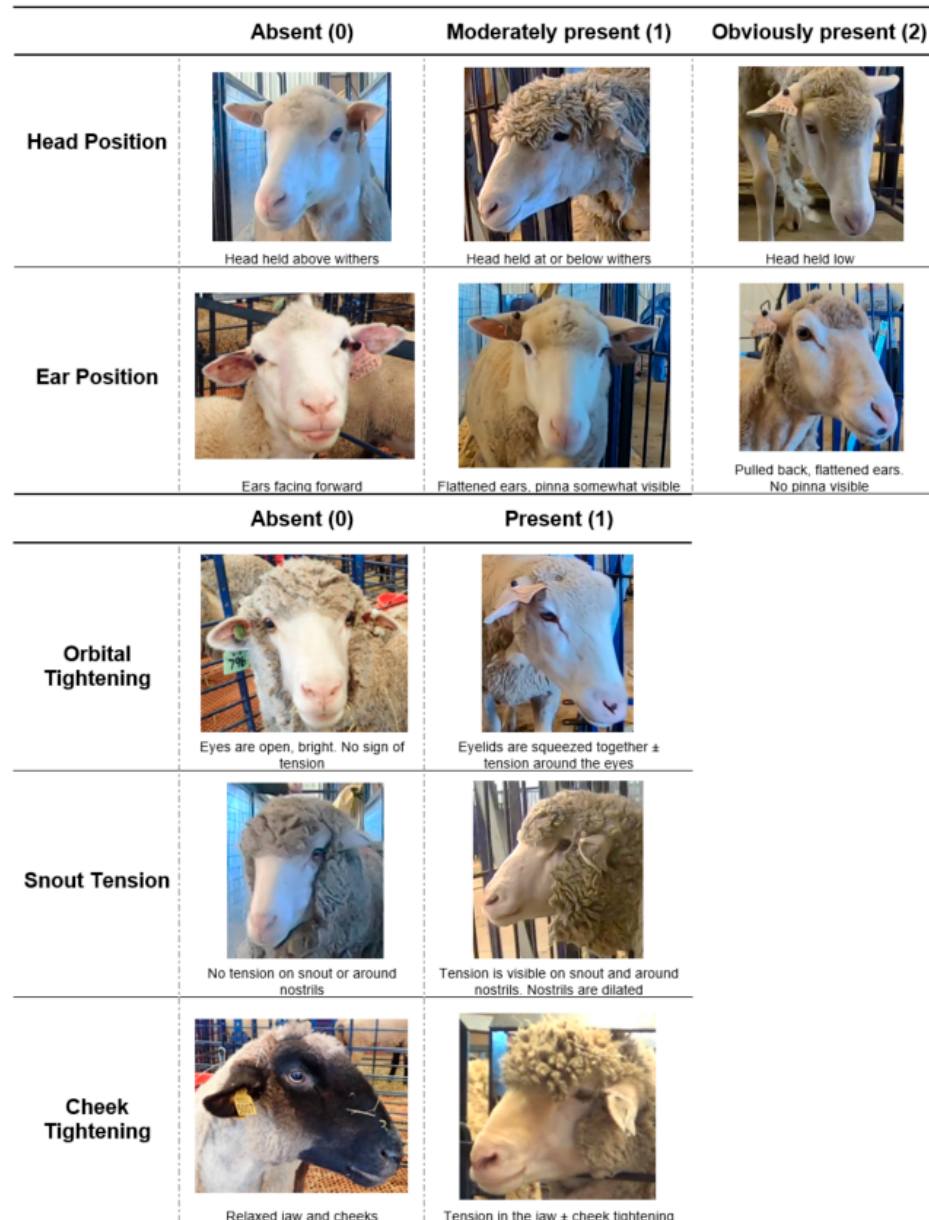
Figure 1. A modified Sheep Grimace Scale (SGS), incorporating facial action units described by McLennan et al. [2] and Häger et al. [23]. This SGS scores head position, ear position, orbital tightening, snout tension and cheek tightening. The maximum score is 7.